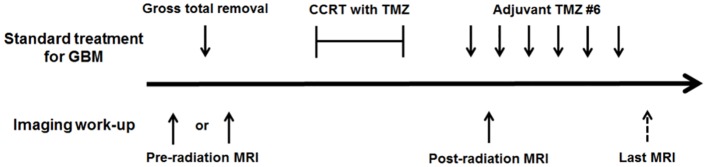
Timeline of patient treatment and the imaging study.The standard treatment for newly diagnosed GBM includes gross total removal of the tumor and concurrent chemoradiotherapy with temozolomide, followed by adjuvant temozolomide. In this study, we enrolled patients who underwent pre- and post-radiation brain MRI including R1 map source images. Pre-radiation MRI included MRI performed either before or after tumor removal. The mean time interval between pre- and post-radiation MRI session was 4.2 ± 2.1 months. Further follow-up brain MRI with R1 mapping was available for 10 patients.